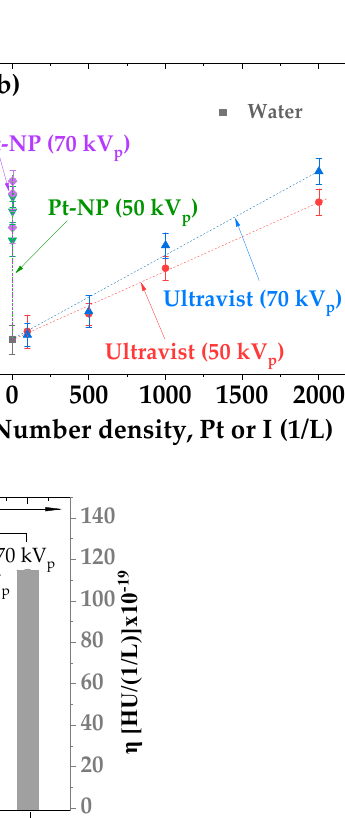
Figure 8. X-ray phantom images of polymer-coated Pt-NPs in aqueous media and Ultravist (X-ray source voltages, 50 and 70 kV p ).